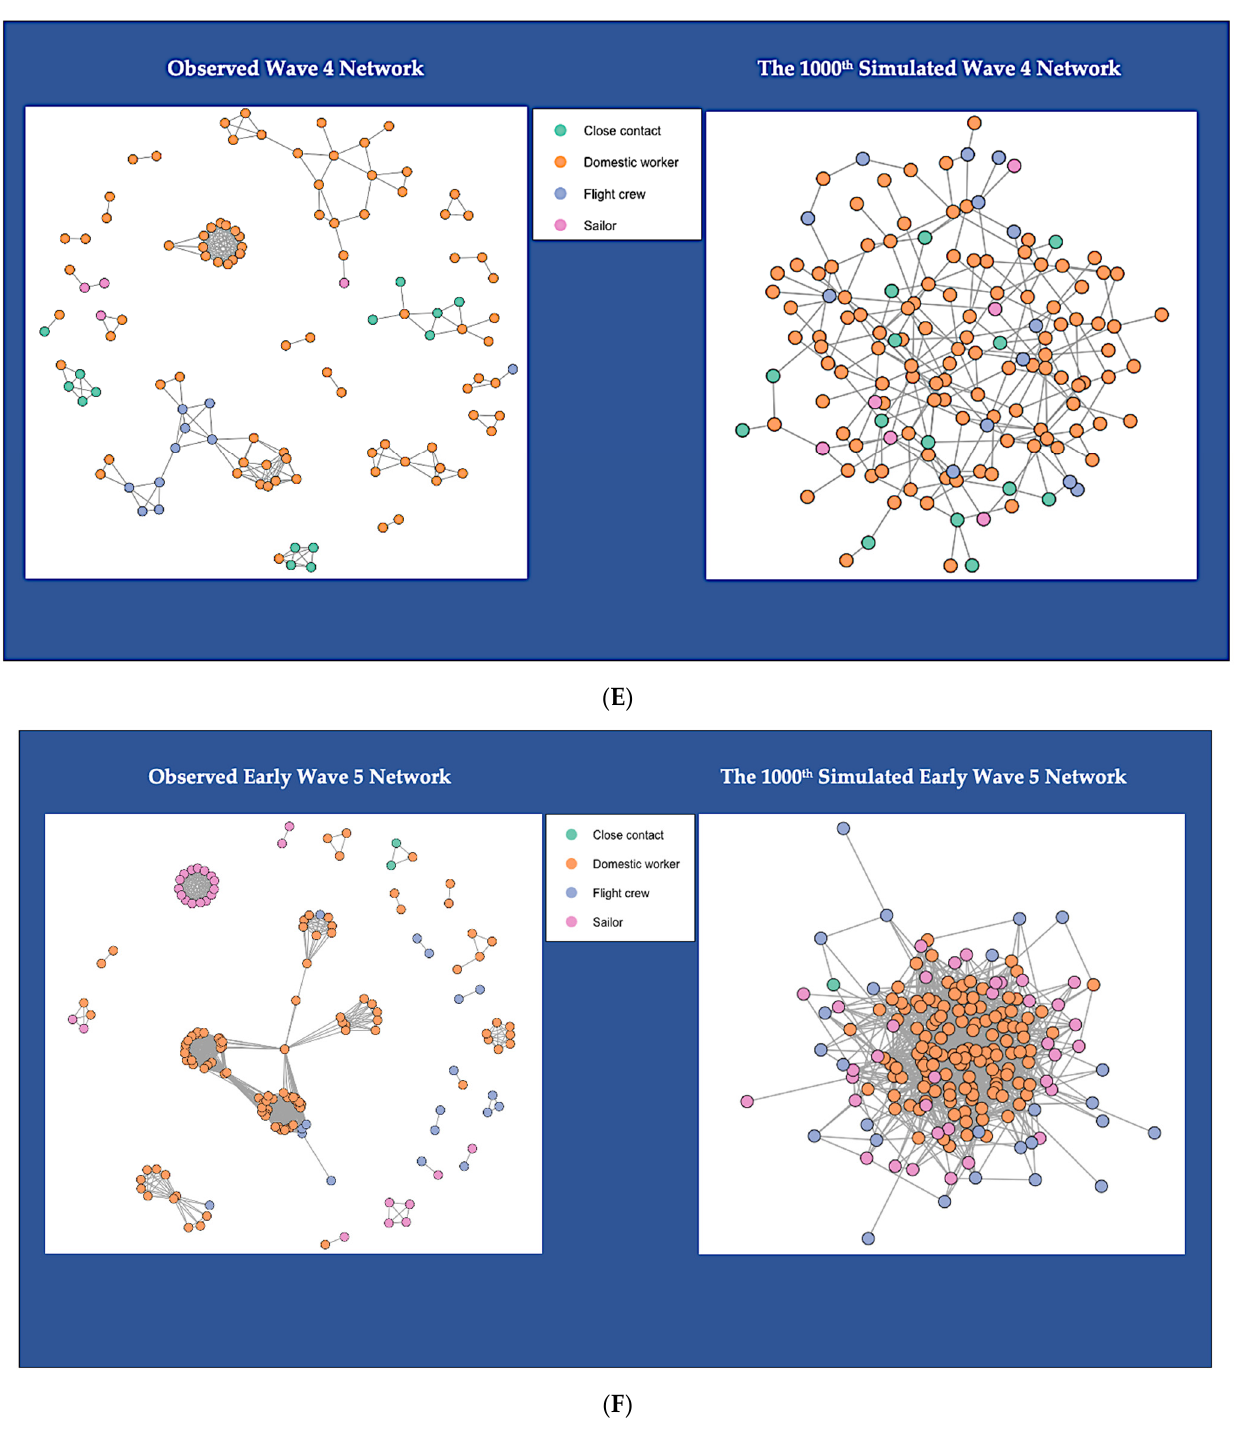
Figure 1. ( A ) Network Topology of Observed and Simulated Networks for Cross-sectional Cohort; ( B ) Network Topology of Observed and Simulated Networks for Wave 1 Cohort; ( C ) Network Topology of Observed and Simulated Networks for Wave 2 Cohort; ( D ) Network Topology of Observed and Simulated Networks for Wave 3 Cohort; ( E ) Network Topology of Observed and Simulated Networks for Wave 4 Cohort; ( F ) Network Topology of Observed and Simulated Networks for Wave 5 Cohort.